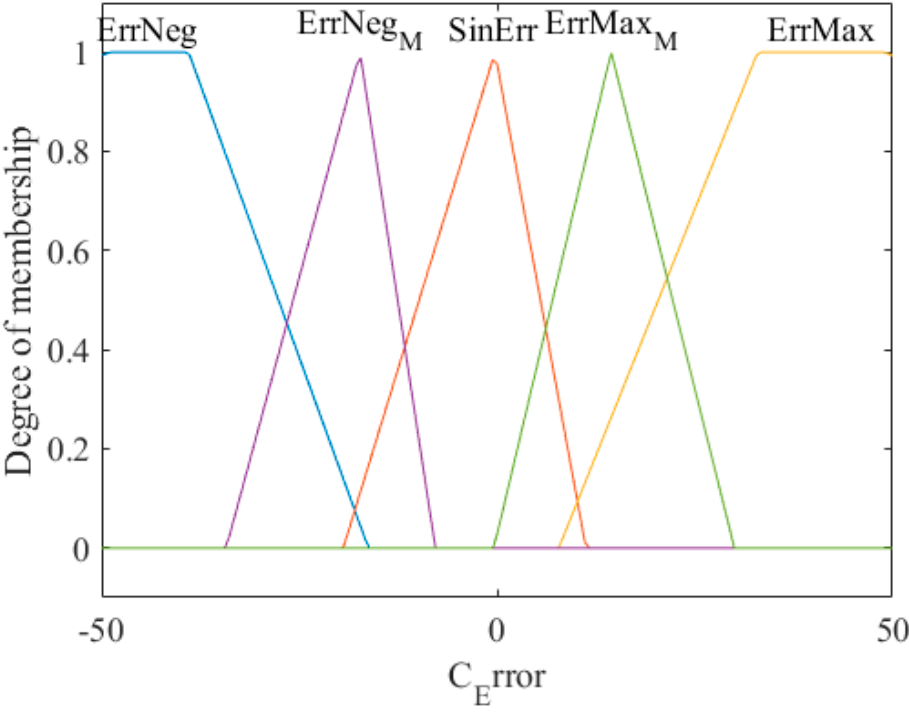
Figure 12. Input 2 for the FLC with signal generator speed reference.